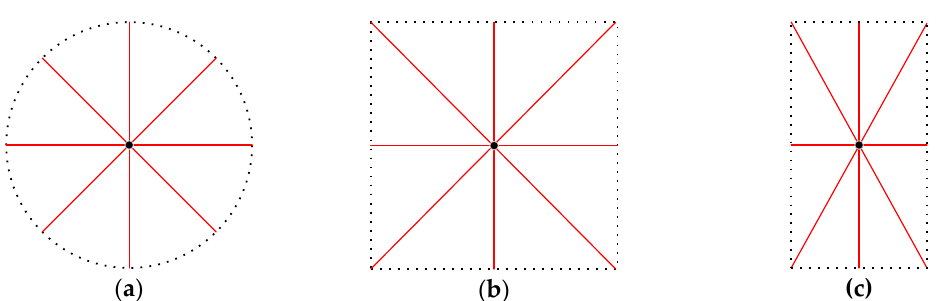
Figure 5. Common regular polygon environments in indoor scenes. ( a ) Circular area; ( b ) square symmetric environment; ( c ) rectangular symmetric environment.